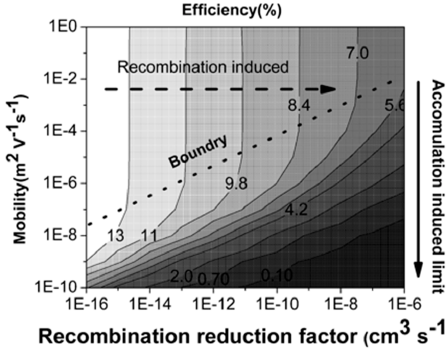
Figure 4. Contour plot presenting the ultimate achievable efficiencies for different ranges of balanced charge carrier mobilties vs. morphology-induced recombination reduction factor.